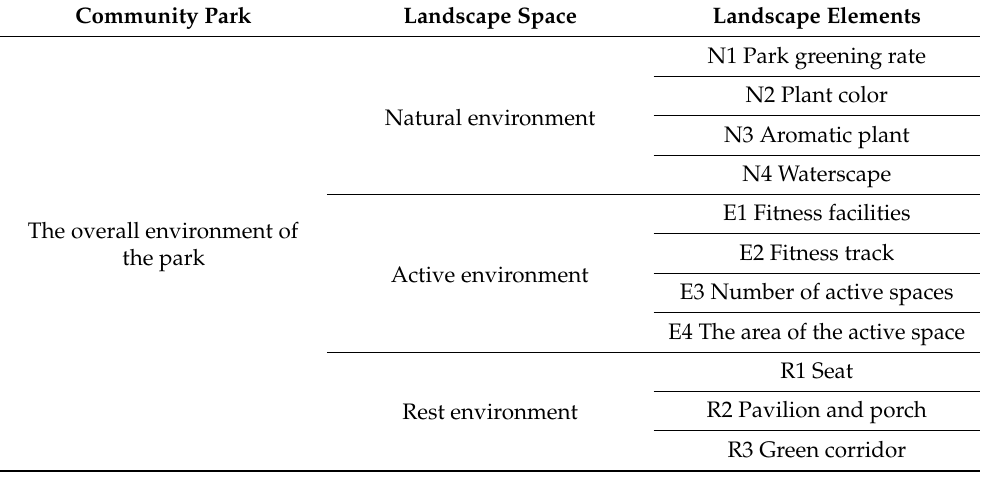
Table 1. Classification of landscape elements in community parks.